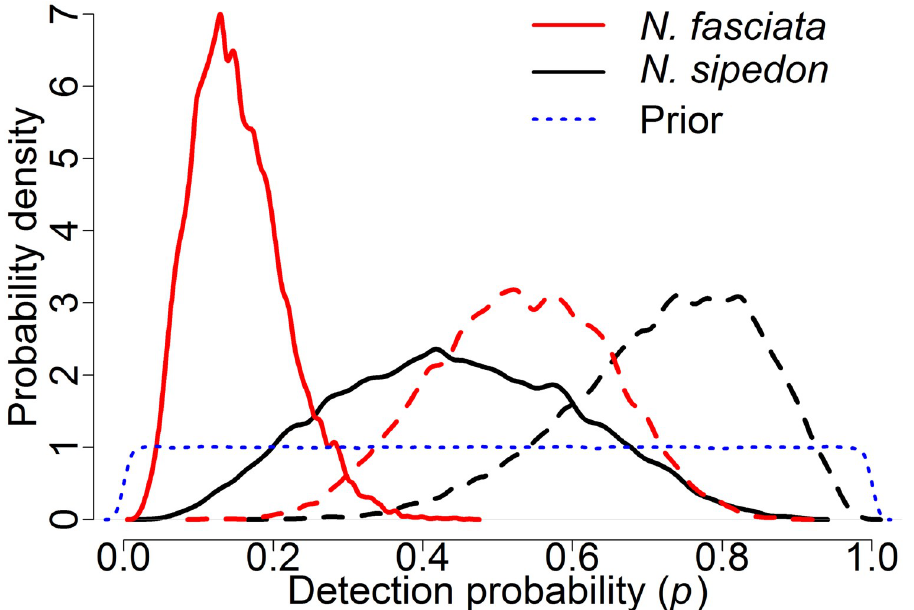
Fig 4. Posterior distributions of detection probability ( p ) for watersnakes. Detection probabilities using eDNA are represented by solid lines and detection probability using trapping are represented using dashed lines. The curves represent the probability of detecting N . fasciata (red lines) or N . sipedon (black lines) at a site, given that they are present, for one water sample (eDNA) or one night of trapping with 30 traps. The blue dotted line represents the Uniform(0,1) prior distribution used for detection probability parameters in the Bayesian occupancy model.